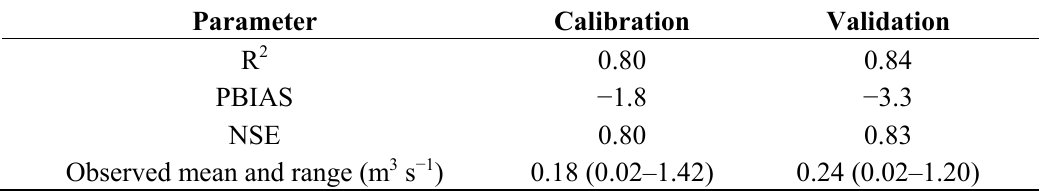
Table 1. Calibration and validation statistics for daily streamflow. R 2 : regression coefficient; PBIAS: percentage of bias; NSE: Nash-Sutcliffe efficiency.